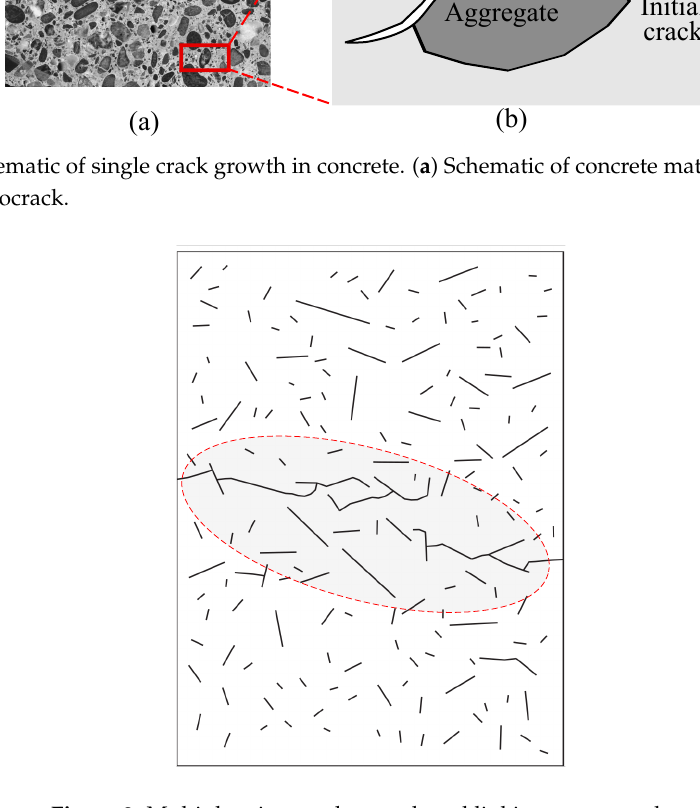
Figure 2. Multiple microcrack growth and linking: an example.